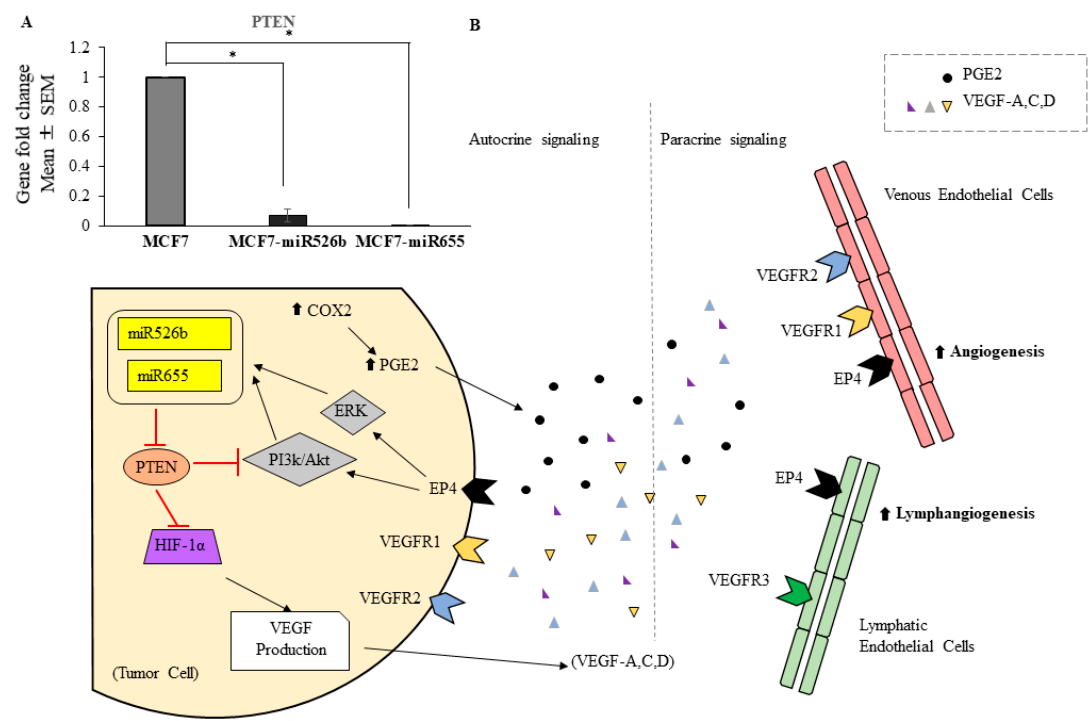
Figure 8. ( A ) miR526b and miR655 overexpressing cells showing significant down regulation of tumour suppressor gene phosphatase and tensin homolog (PTEN) mRNA expression. Data are represented as mean ± SD.; * ( p < 0.05). ( B ) The proposed pathway of tumour associated angiogenesis and lymphangiogenesis promotion by miR655 and miR526b. miRNA over expressing cells are high in COX-2 expression, resulting in production of PGE2 and its subsequent release into the tumour microenvironment. PGE2 can signal through EP4 in both an autocrine and paracrine fashion. Signalling through EP4 on tumour cells stimulates ERK and PI3k / Akt signalling pathways, resulting in the upregulation of miR526b and miR655. Subsequently, miR526b and miR655 target tumour suppressor gene PTEN . Thus, the inhibitory e ff ect of PTEN on hypoxia-inducible factor-1 (HIF-1a), as well as the PI3K / Akt pathway, is prevented by upregulation of these miRNAs. Without regulation, transcription factor HIF-1a promotes VEGFA, C, D transcription, and thus an overproduction of VEGFs and their subsequent release into the tumour microenvironment for both autocrine and paracrine signalling. VEGF molecules will bind to various VEGF receptor (VEGFR1, VEGFR2) molecules present on vascular endothelial cells (VECs) and lymphatic endothelial cells (LECs) to promote angiogenesis and lymphangiogenesis, respectively. In the absence PTEN ’s regulation on PI3k / Akt pathway within the tumour cell, growth and proliferation is